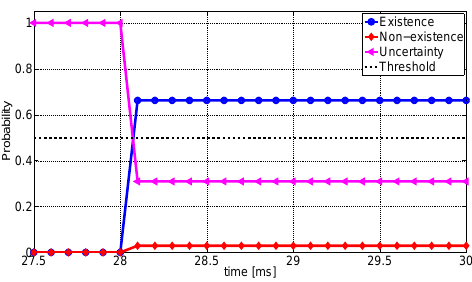
Figure 12. Changes of confidences about { E,N,U } for